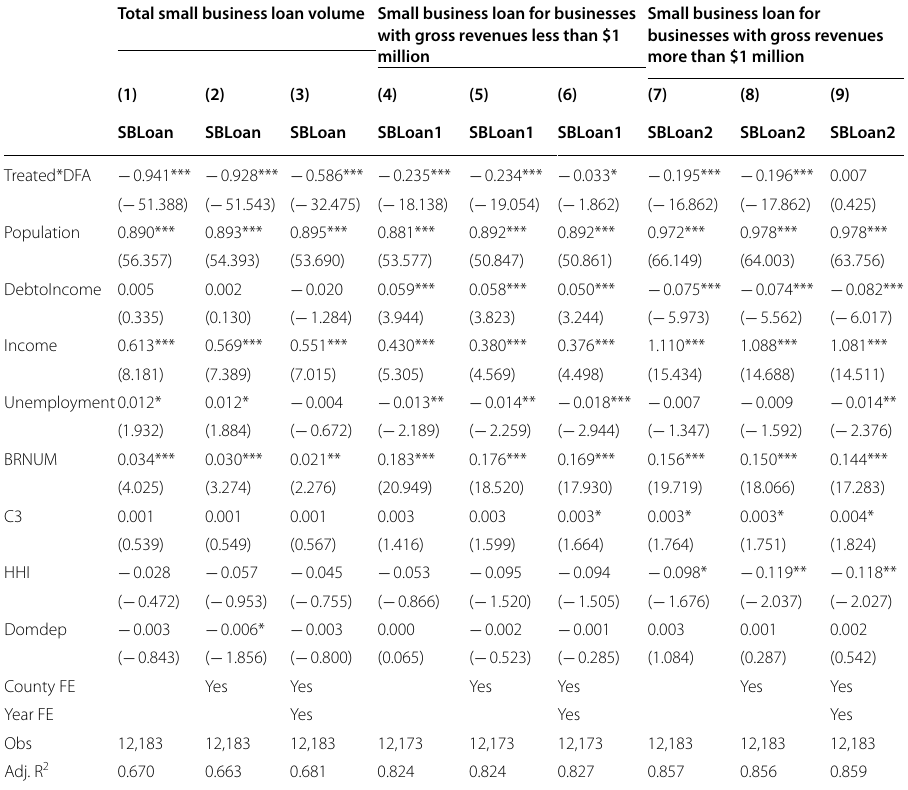
Table 6 Impact of Dodd-Frank Act on aggregate county-level small business